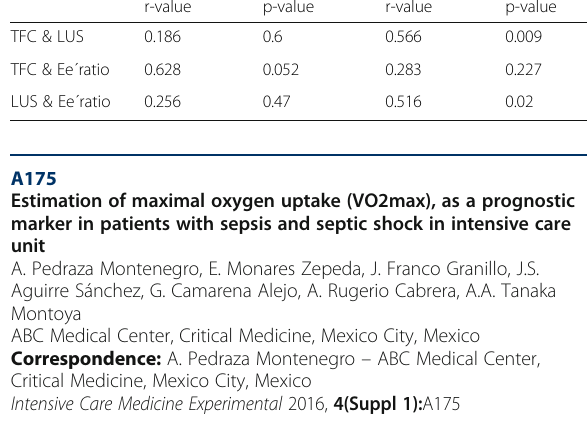
Table 58 (abstract A174). Correlation between TFC, LUS, Ee' (Day 3) Positive- balanced patients